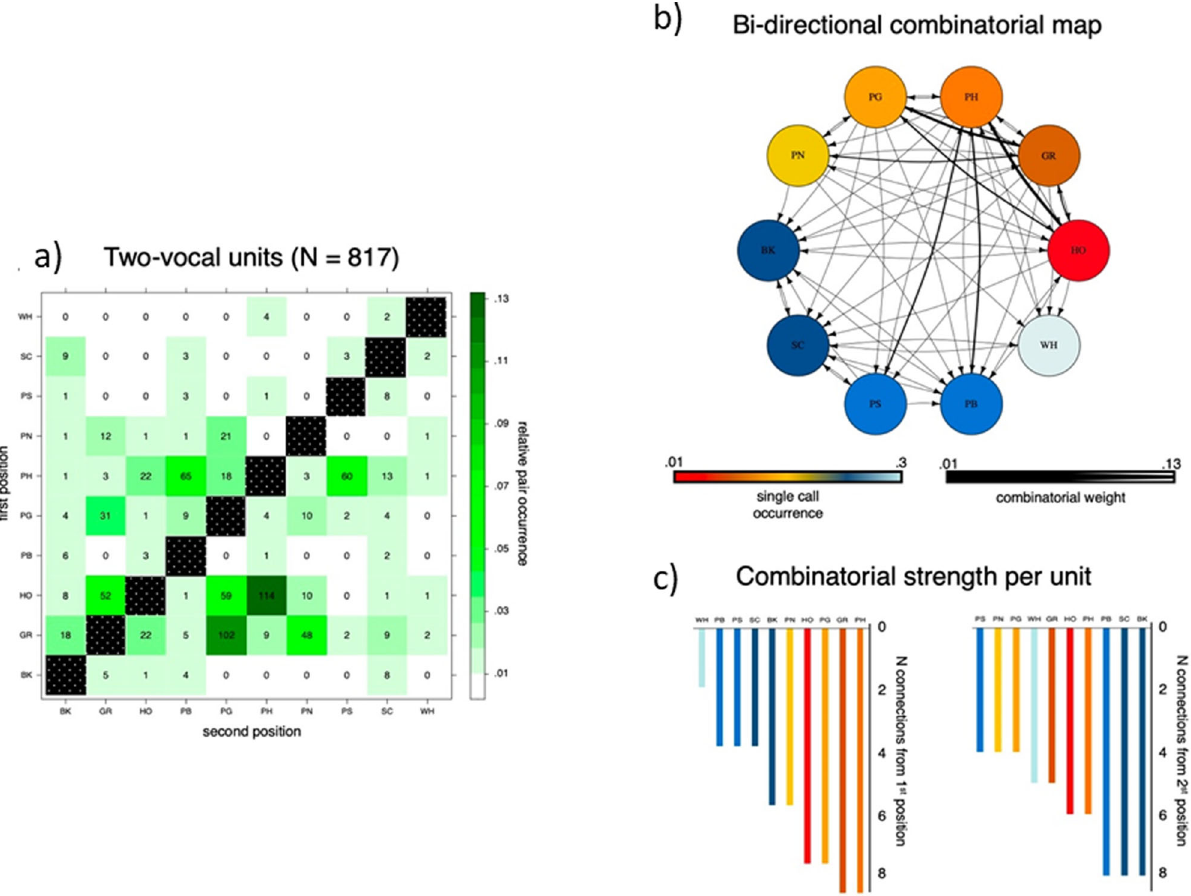
Fig. 2 Bigram fl exibility and ordering ( N = 817 bigrams and 58 unique bigrams). a Frequency distribution for two-unit vocal sequences (bigrams) with units occurring in fi rst position listed along the y axis and units occurring in second position listed along the x axis. Color gradients (white-to-dark-green) represent the relative occurrence of each bigram within the two-units ’ set. In each cell, the absolute frequency count for each bigram is conversely reported. b The bigram combinatorial network with the ten single units depicted as circled nodes and color gradients (hot-to-cold) representing the number of times a certain unit is found in the bigram set. Note that the single units (NV) and (PR) that never occurred in bigrams are not shown here. This network was also used for the calculation of the Betweenness Centrality among the units. The size of the directional edges (arrows) expresses the number of times the speci fi c bigram is found in the sample (thick-to-thin). c The number of different single units with which each single unit forms a bigram in the sample as fi rst unit (left) or second unit in the bigram